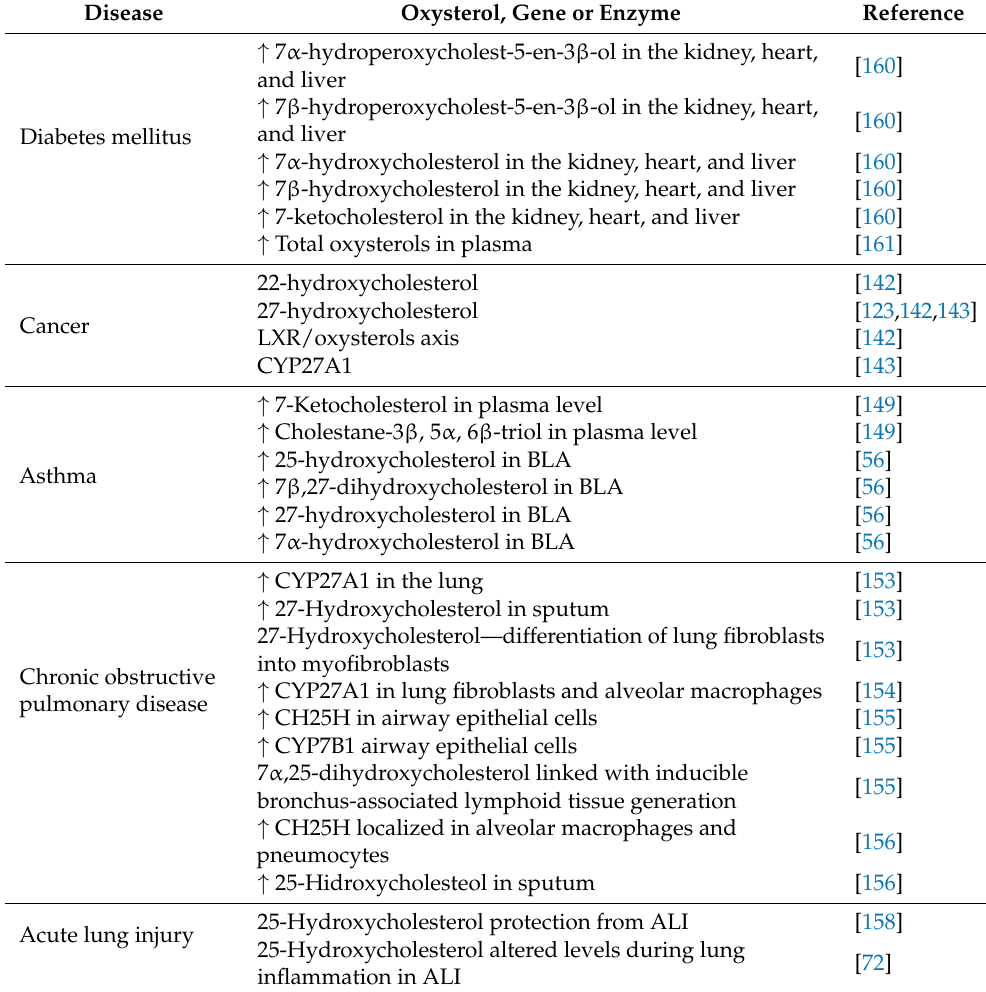
Table 1. Cont. Disease Oxysterol, Gene or Enzyme